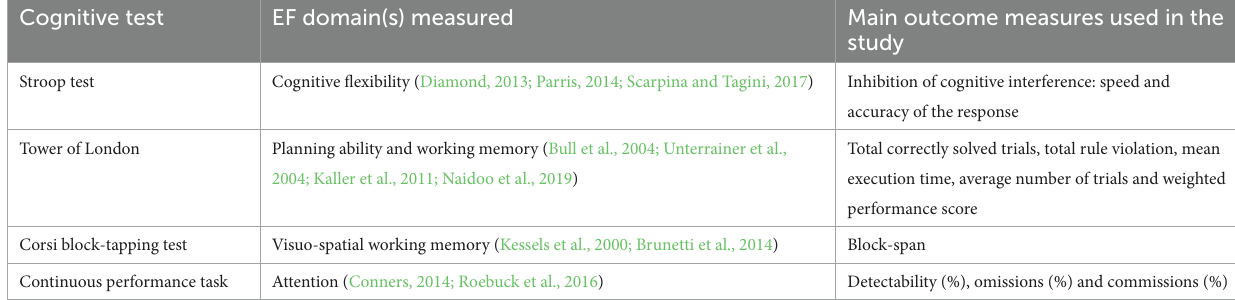
TABLE 1 Cognitive tests used in the study to measure executive